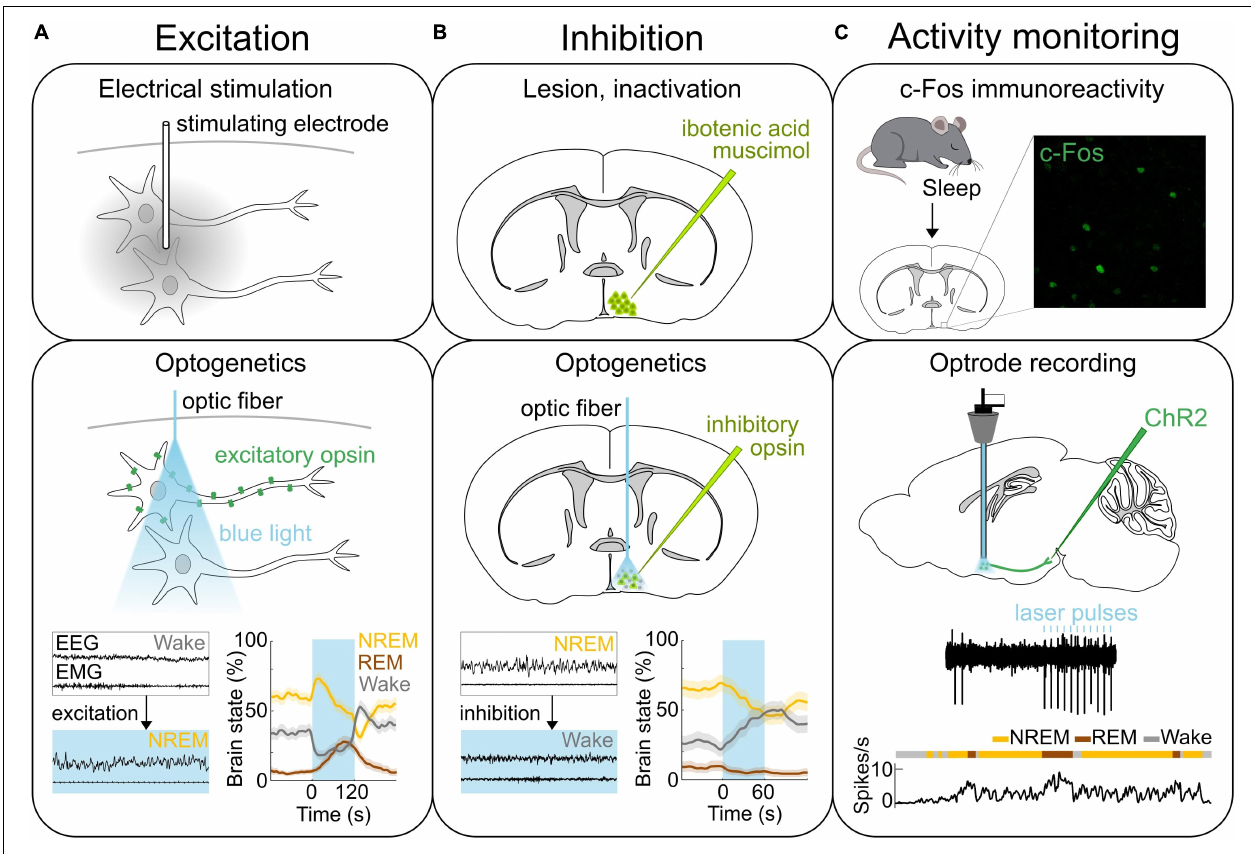
FIGURE 1 | Methods of neural activity manipulation and monitoring. (A) Methods for activating neurons. Top, Electrical stimulation allows for activating neurons in the area where the stimulating electrode is located. Middle, Expressing light-activated excitatory opsins such as channelrhodopsin-2 (ChR2) in genetically-defined neurons allows for the manipulation of specific neural populations on the order of milliseconds using light (Deisseroth, 2015; Grosenick et al., 2015; Deisseroth and Hegemann, 2017; Kim et al., 2017). Bottom, Optogenetic stimulation of ChR2 expressing GABA POA → TMN neurons promotes sleep. Bottom left, Example EEG and EMG traces before and during laser stimulation (blue shading). Bottom right, Percentage of time in NREM, REM or wake state before, during, and after laser stimulation (blue shading). (B) Methods for inactivating neural activity. Top, The specific brain region can be lesioned or inactivated for example by injecting the neurotoxin ibotenic acid or muscimol. Middle, Expression of light sensitive inhibitory opsins in genetically-defined neurons enables the inhibition of specific neural populations (Wiegert et al., 2017). Bottom, Optogenetic inhibition of the iC++ expressing GABA POA → TMN neurons suppresses sleep. Left, Example EEG and EMG traces before and during laser stimulation (blue shading). Right, Percentage of time in NREM, REM or wake state before, during, and after laser stimulation (blue shading). (C) Methods for recording neural activity. Top, c-Fos immunohistochemistry has been used to detect neurons in the POA that are activated following sleep. Example POA neurons stained for expression of c-Fos (green) following deprivation-induced sleep rebound. Middle and bottom, Optrodes allow for identifying ChR2-expressing neurons and recording their spiking activity during sleep and wakefulness. An example recording from GABA POA → TMN neurons. Reproduced from Chung et al. (2017). Sagittal and coronal brain scheme adapted from Allen Mouse Brain Atlas (©Allen Brain Atlas API. Available from